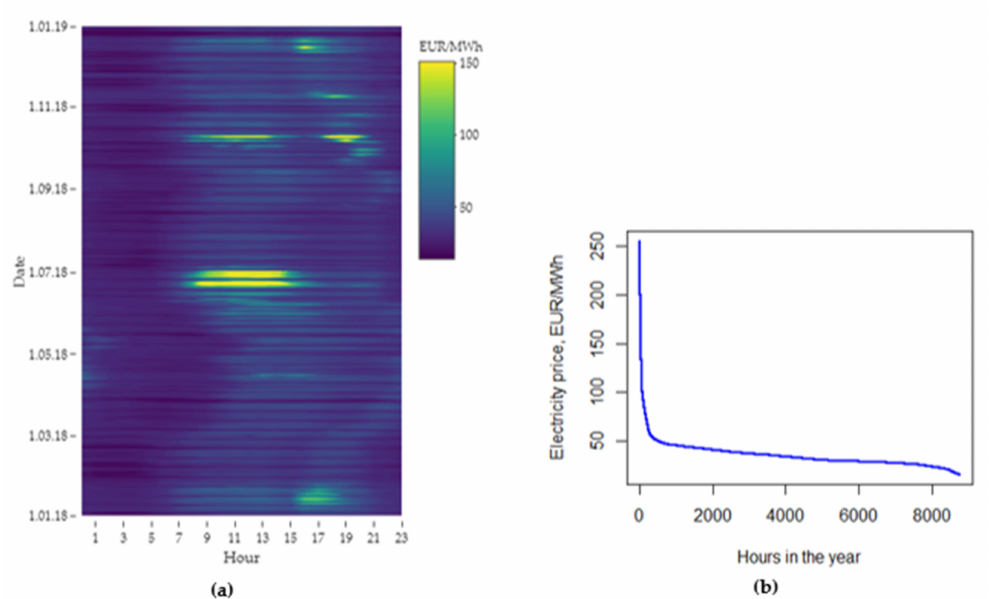
Figure 5. ( a ) The annual pattern of electricity prices on the Day-Ahead Market in the Polish Power Exchange in analyzed period. ( b ) Ordered data of electricity prices on the Day-Ahead Market in the Polish Power Exchange in the analyzed period. Source: own